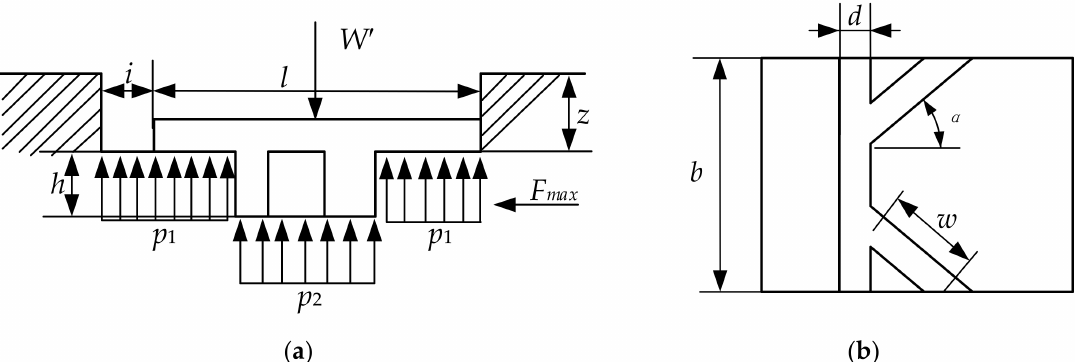
Figure 5. Schematic diagram of the interaction force between a K-shaped track shoe and the soil. ( a ) Side view of the force diagram of a K-shaped track shoe. ( b ) Dimension diagram of a K-shaped track